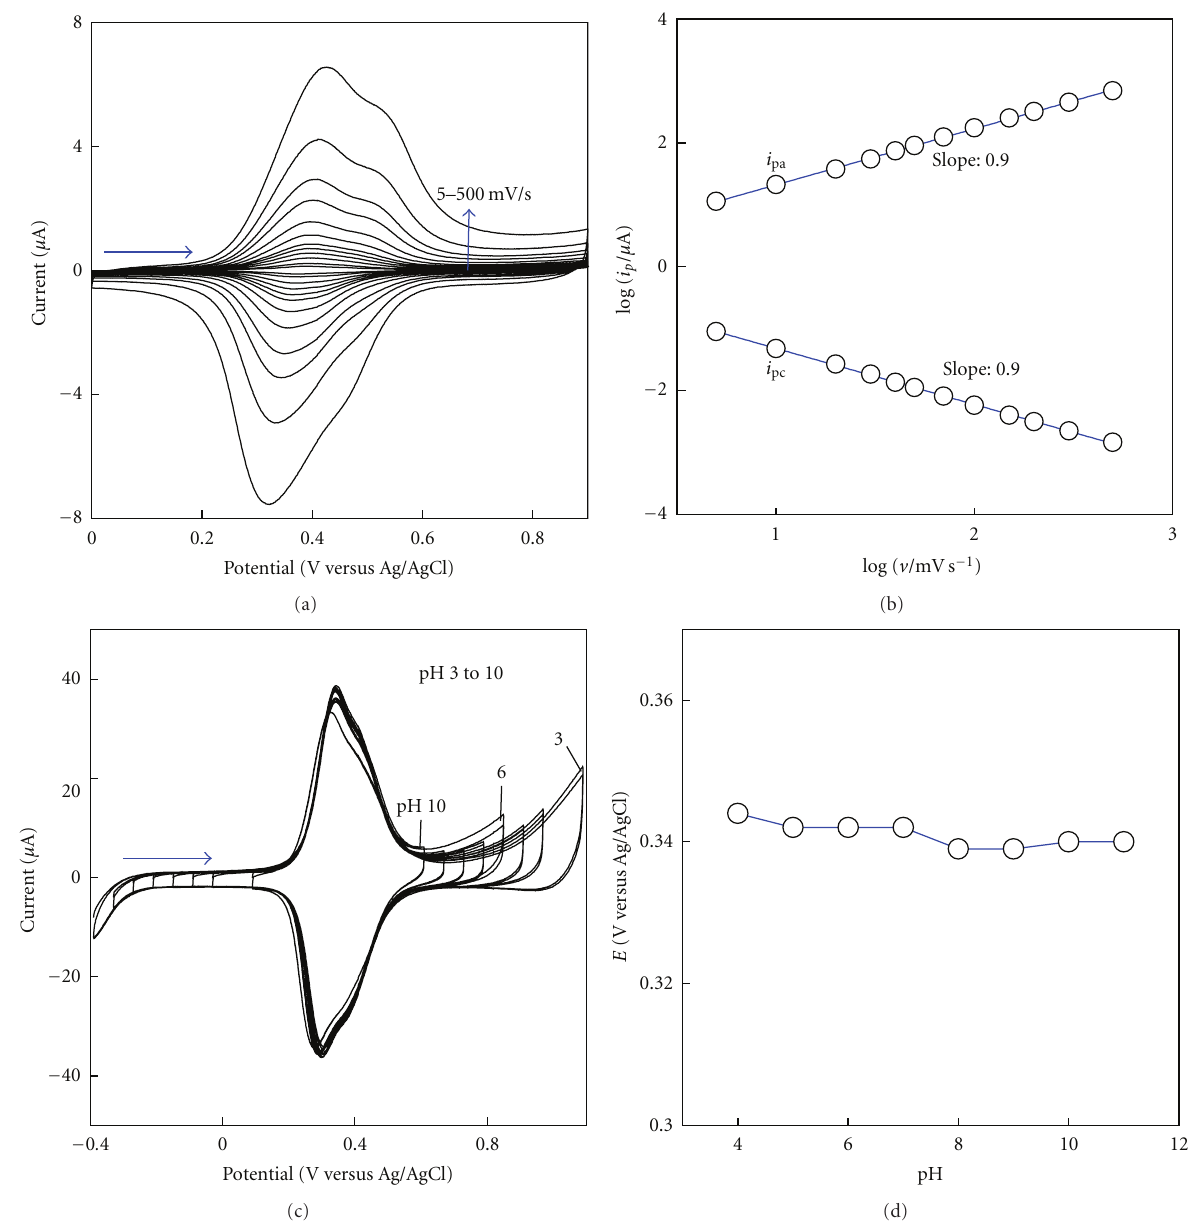
Figure 3: E ff ect of CV scan rate (a) and pH (c) on GCE/NiHCFe@GMC in pH 7 PBS and its typical plots (b) and (d). Scan rate = 50 mV s − 1